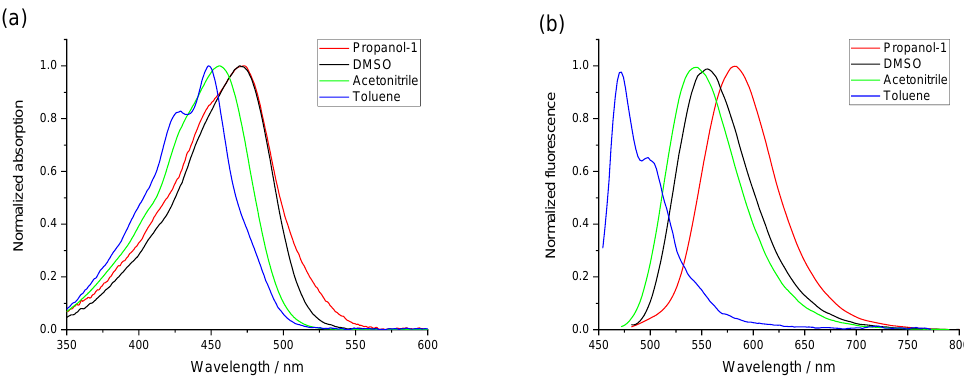
Figure 2. ( a ) Normalized 4Met-BAC absorption spectra in different solvents. ( b ) Normalized 4Met- BAC fluorescence spectra in different solvents. Table 1. Absorption and emission data of 4Met-BAC in different solvents.